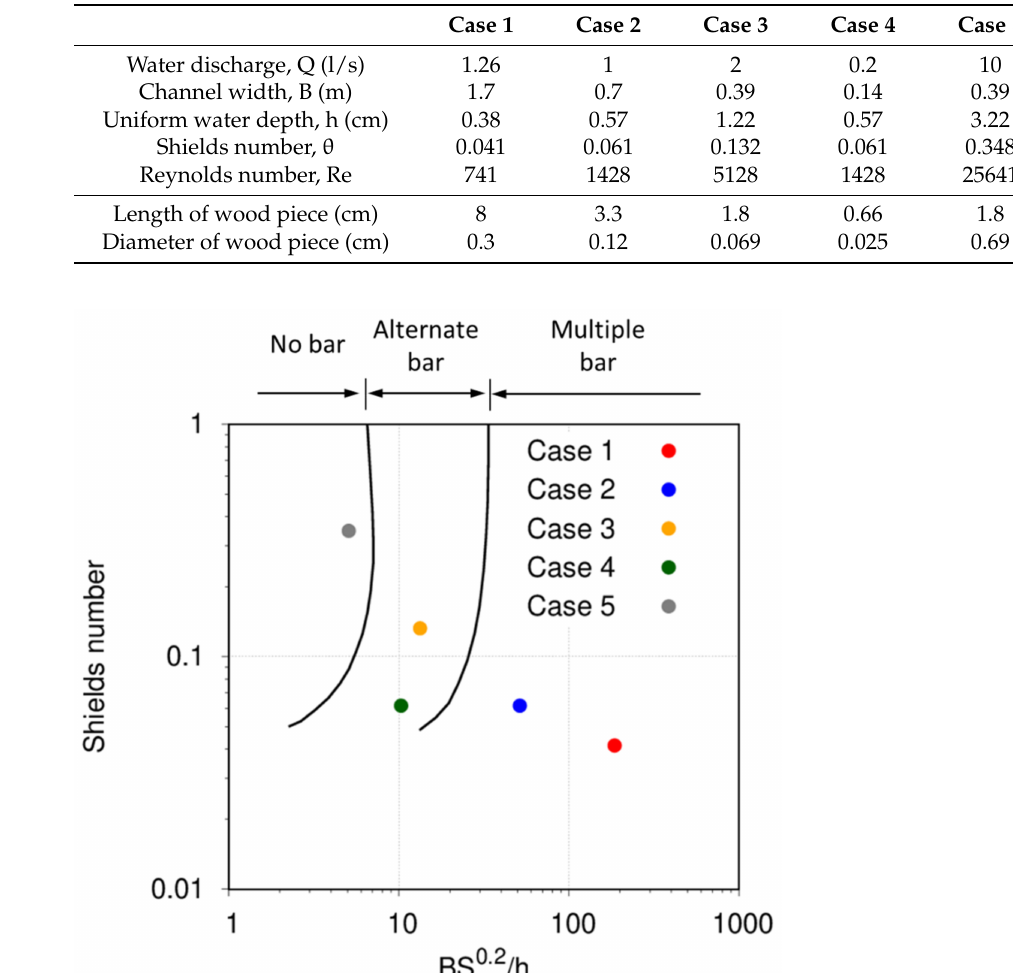
Table 1. Computational conditions for numerical simulation.